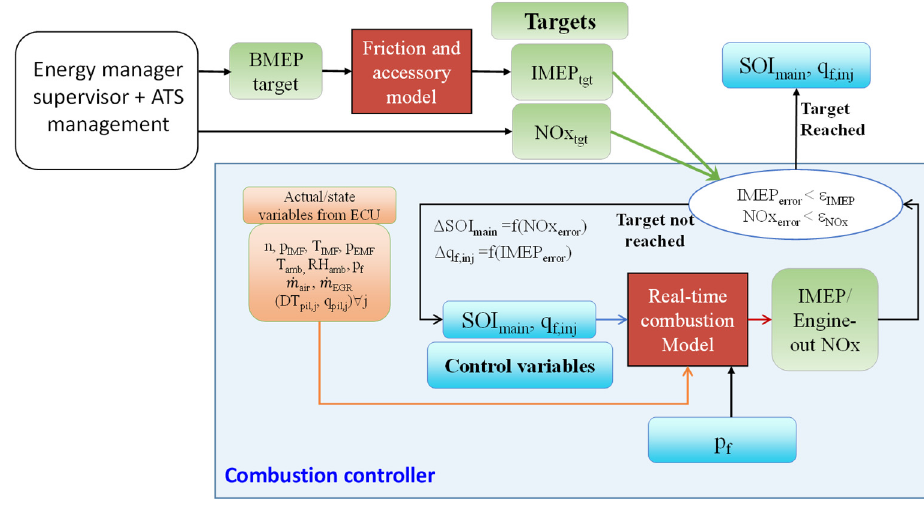
Figure 2. Schematic of the controller developed during the IMPERIUM